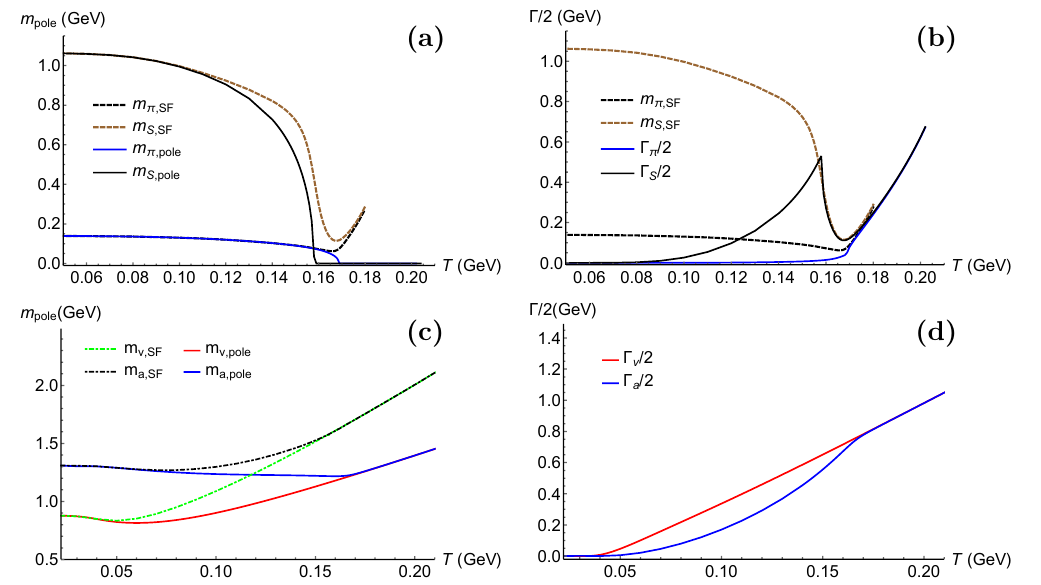
Figure 5 . The dependence of the pole masses and the widths on temperature with physical quark mass m q = 3 . 22 MeV. Pole masses (a) and thermal widths (b) of the scalar meson ( m S , pole , Γ S ) and pion ( m π, pole , Γ π ). Pole masses (c) and thermal widths (d) of the vector meson ( m v , pole , Γ v ) and axial-vector meson ( m a , pole , Γ a ). The quasiparticle masses of the scalar meson and the pion extracted from the spectral functions, taken from ref. [91], are shown as the dashed lines in (a) and